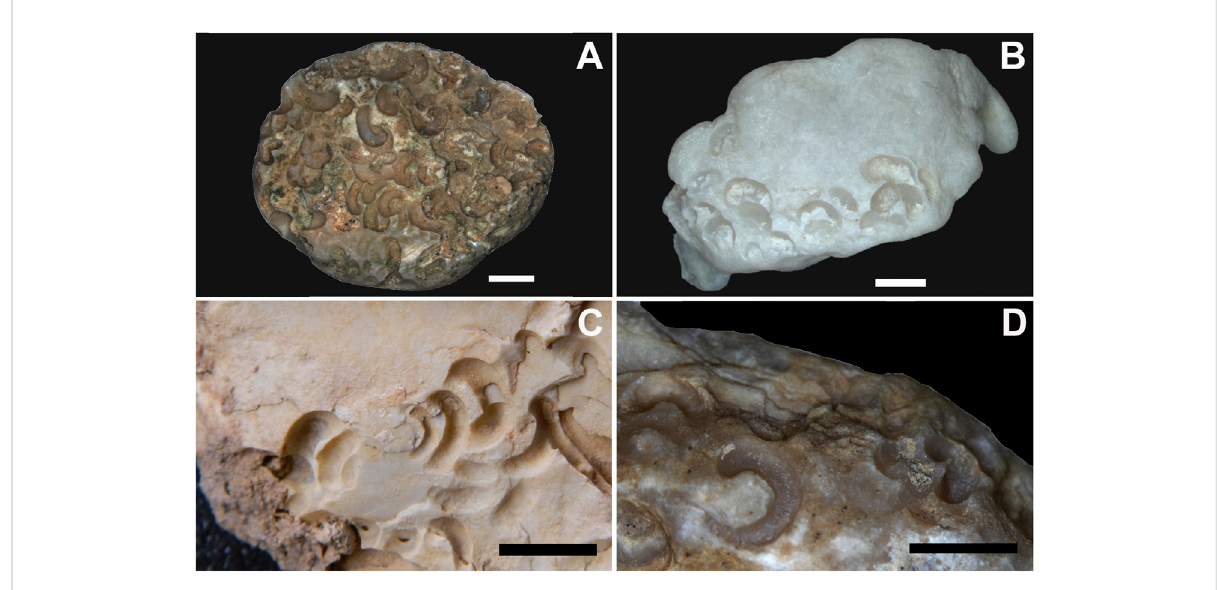
FIGURE 2 Examples of Renichnus arcuatus Mayoral, 1987 from three of the studied localities. (A) ULL PA 520 (Barranco León). (B) ULL PA 473 (Playa del Valle). (C) ULL PA 501 and (D) ULL PA 502 (Playa Aljibe de la Cueva). Scale bars: 5